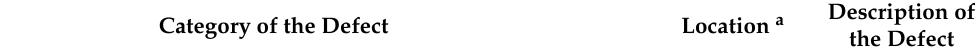
Table 5. Monitoring sheet for the handover of completed ceramic tiling work. Category of the